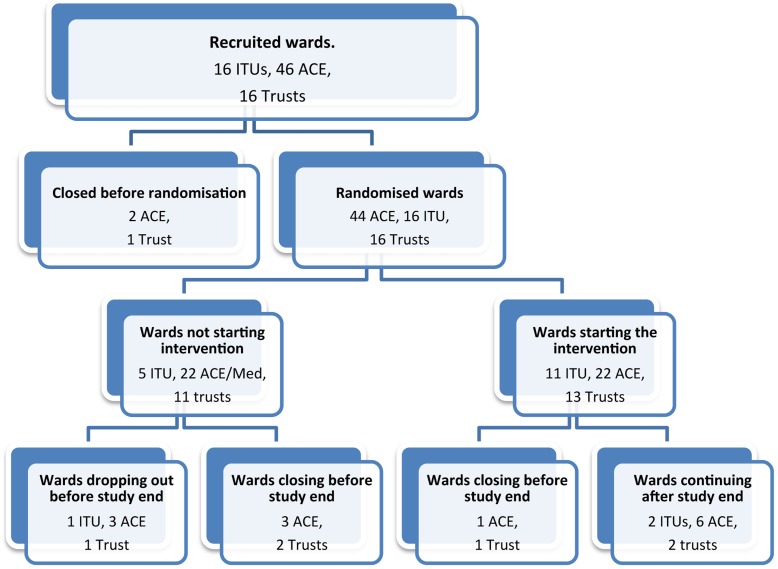
Flowchart showing study recruitment and attrition.